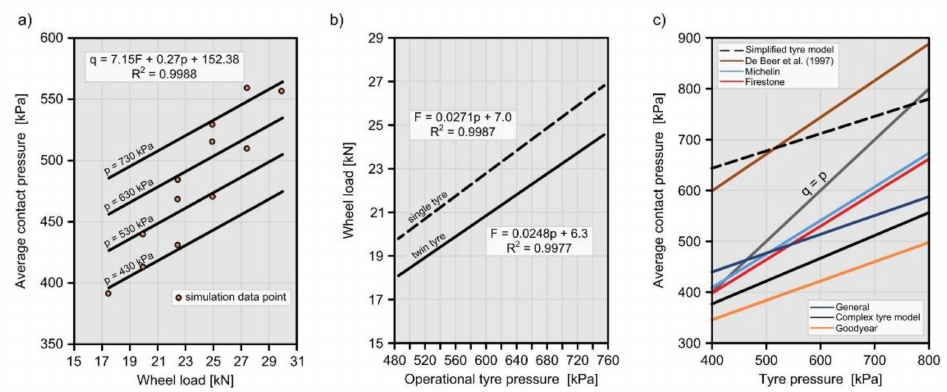
Figure 11. The average contact pressure of the twin tyre depending on the inflation pressure and the (F/2) wheel load ( a ); the connection between the operational tyre pressure recommended by the manufacturer and the (F/2) wheel load ( b ); the connection between the average contact pressure and the operational tyre pressure ( c